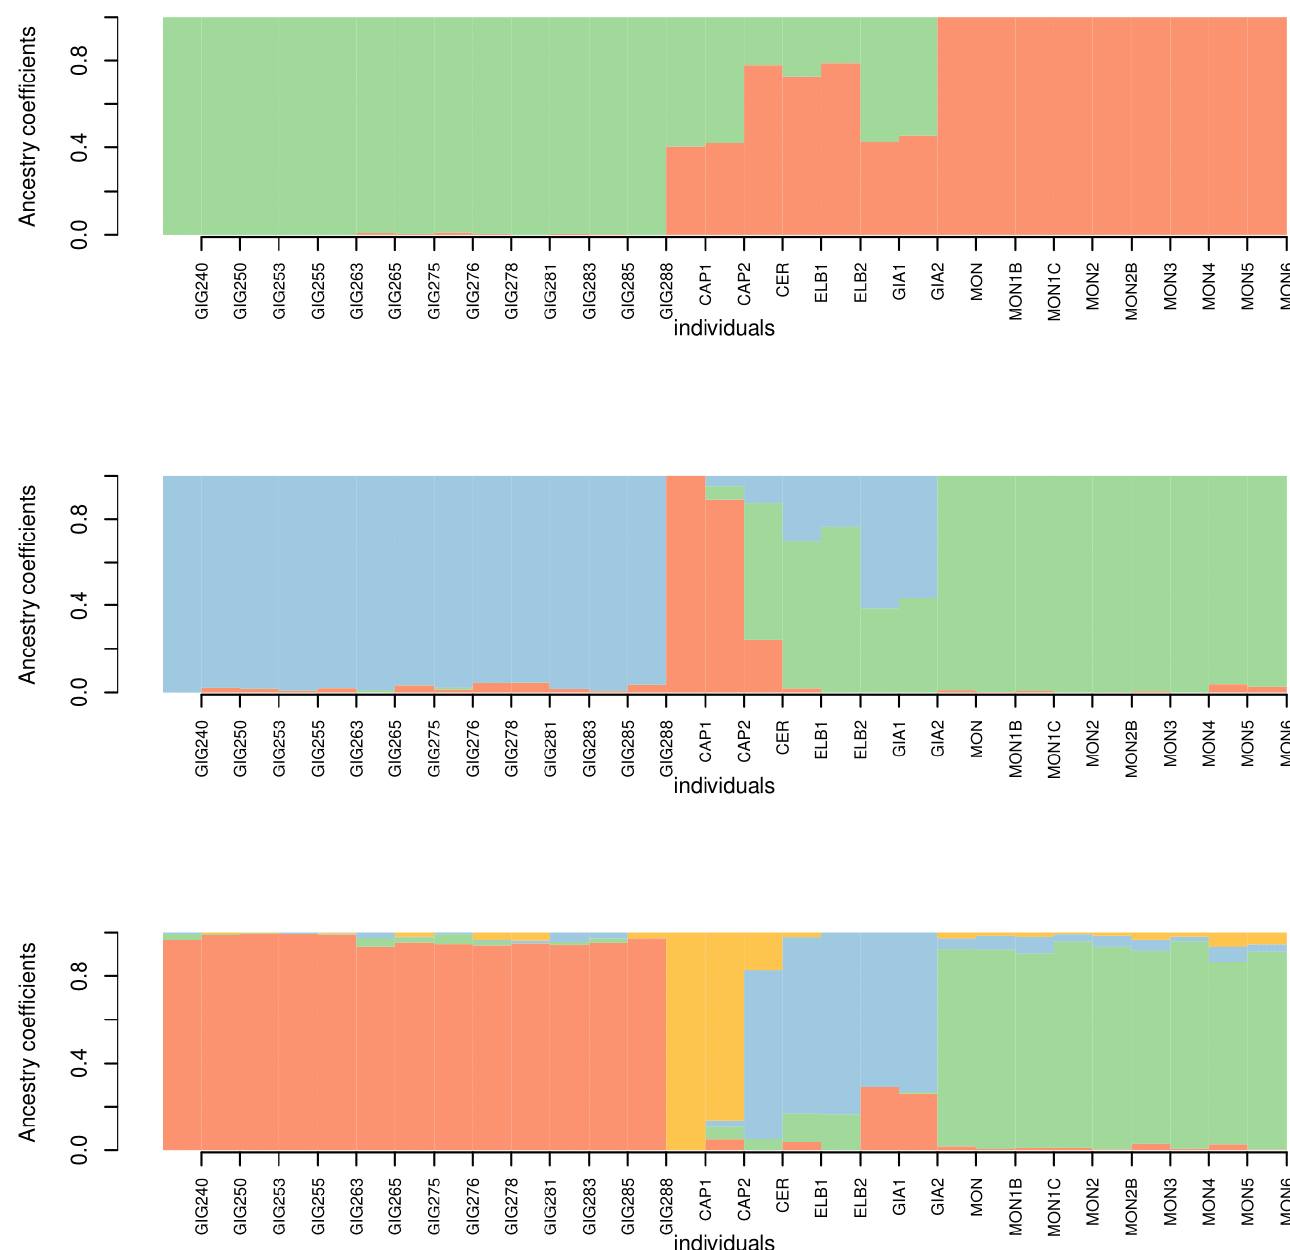
Figure 8. Bar plots for k = 2 to k = 4 (top to bottom). The names of the individuals are labelled below separated by thin white vertical lines (GIG = Giglio, CAP = Capraia, CER = Cerboli, ELB = Elba, GIA = Giannutri, MON = Montecristo).